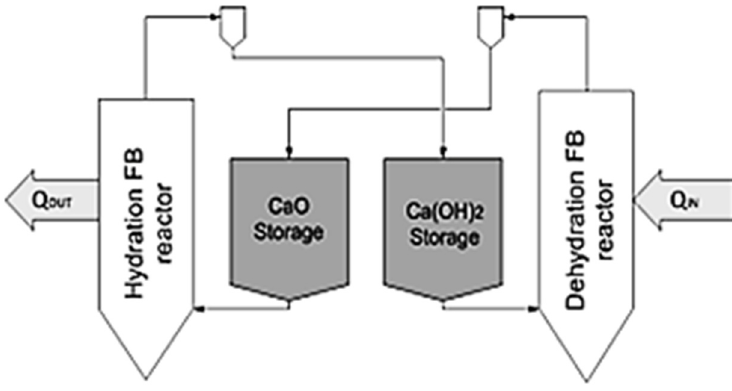
Figure 15. Basic conceptual scheme of the CaO/Ca(OH) 2 energy storage system [146].